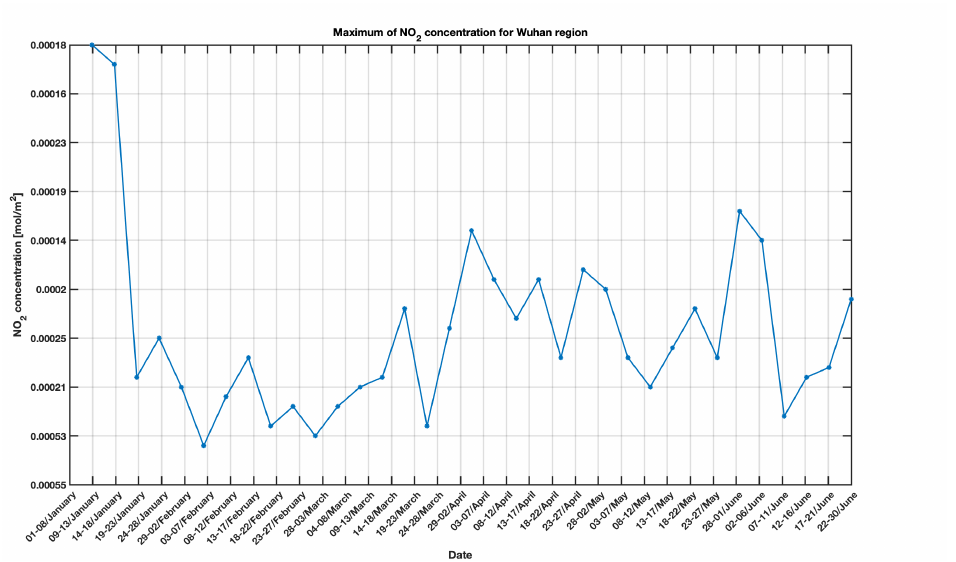
Figure 14. Maximum NO 2 concentration for Wuhan